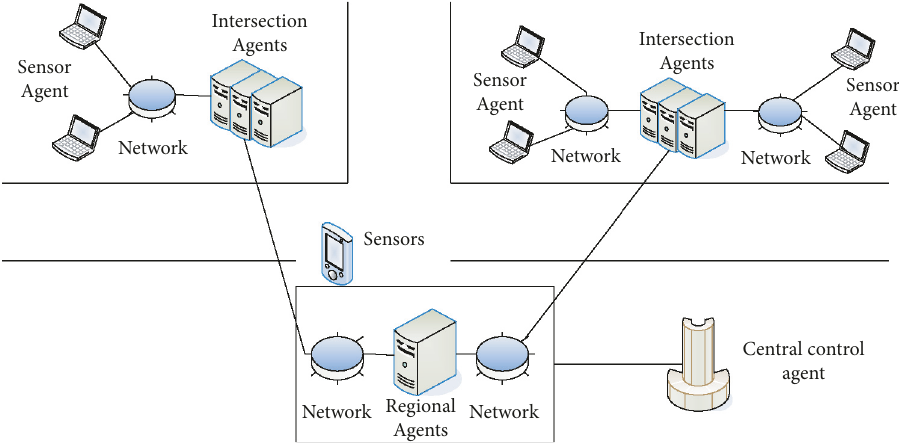
Figure 5: Network layout of the